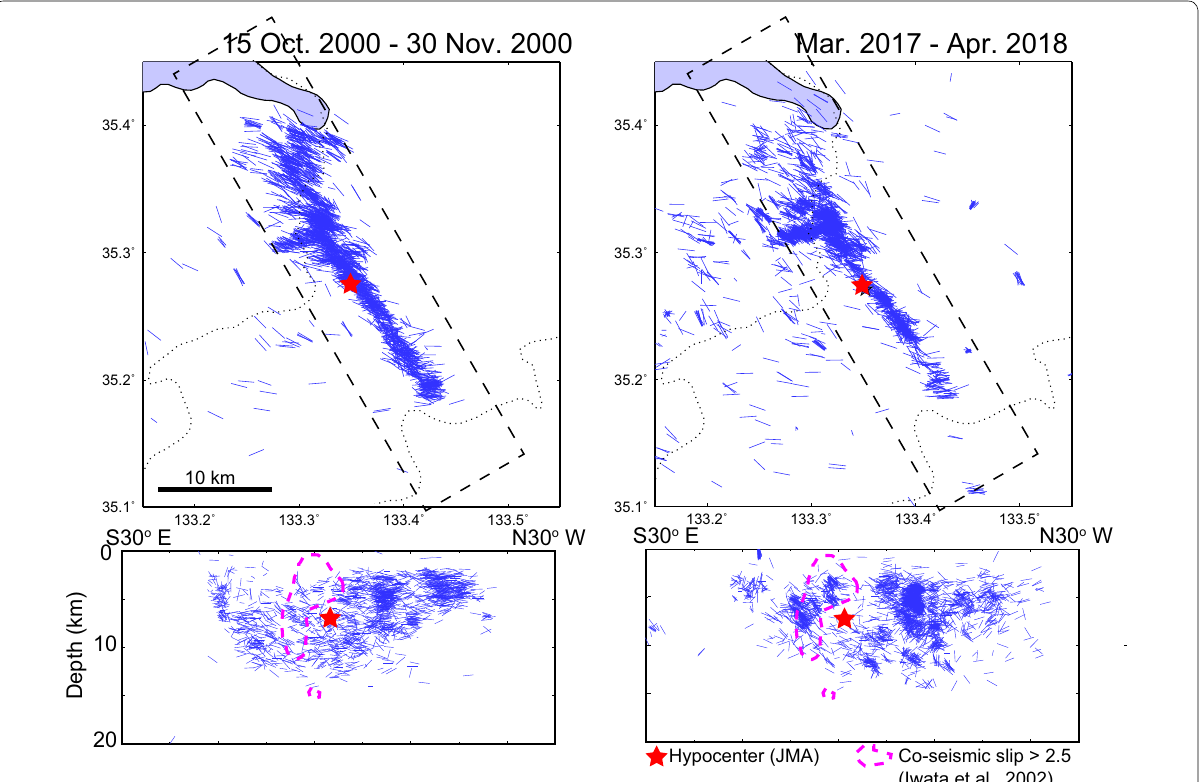
Fig. 4 Map view and vertical cross-section of P-axis distribution along the main shock fault. P-axes of the events located in the dashed rectangle on the map are plotted on the cross-section; left and right figures show data immediately after and 18 years. after the main shock, respectively. The star indicates the hypocenter of the main shock. The area where co-seismic slip is larger than 2.5 m (Iwata et al. 2002) is indicated by a pink dashed